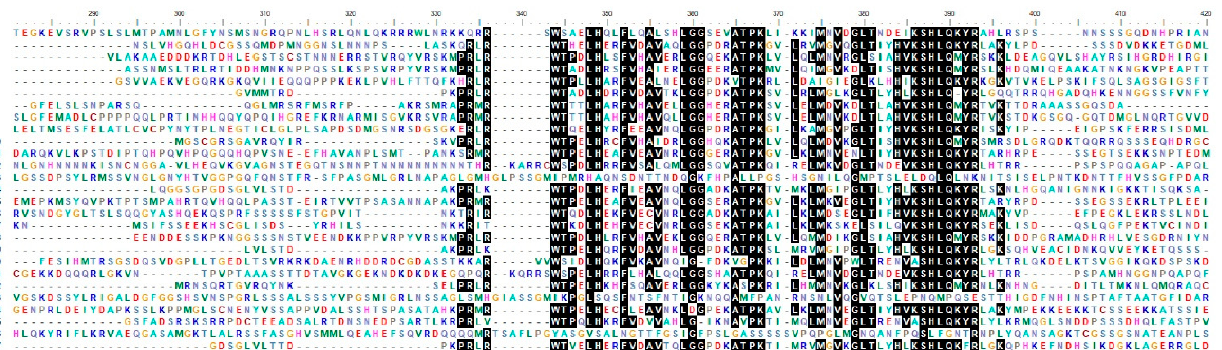
Figure 3. Multiple sequence alignment of the CsGLKs conserved domain. The same sequence was shown in black shadow.